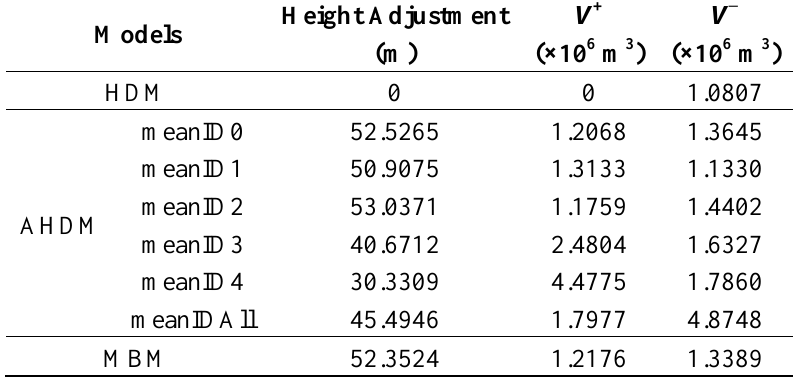
Table 5. Results obtained using different models and for different